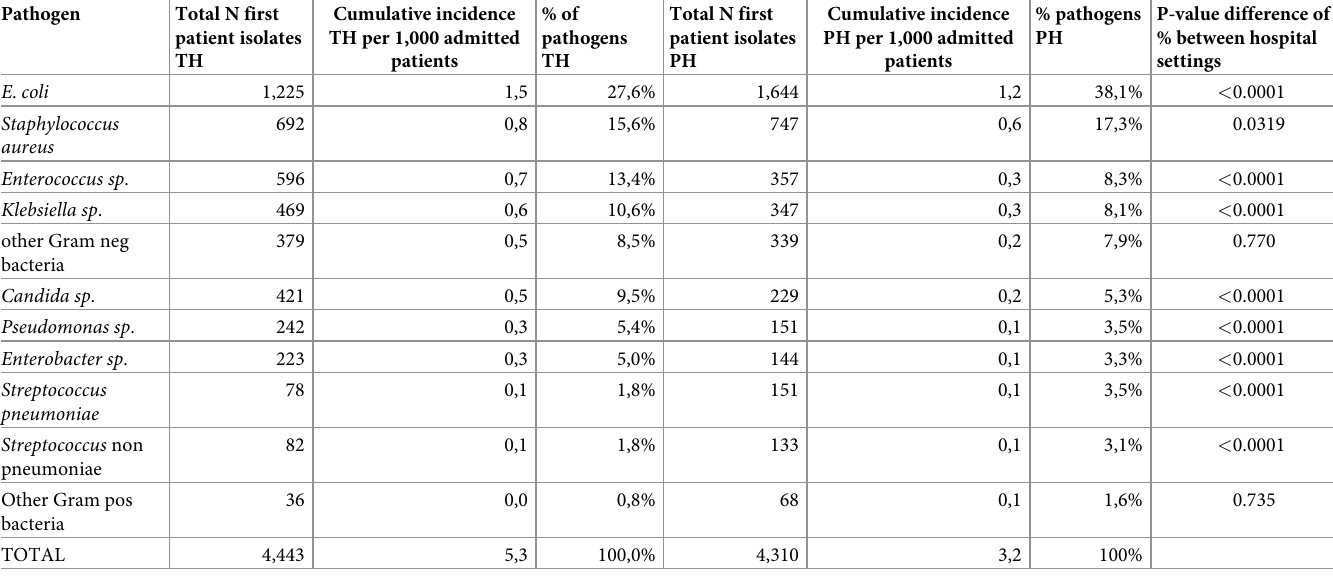
Table 2. Number, most commonly isolated pathogens, cumulative incidence/ 1,000 admitted patients by hospital setting.